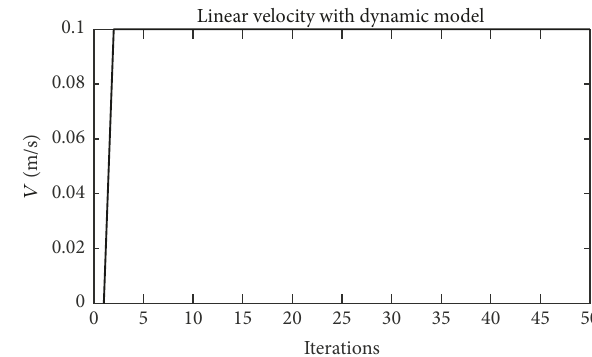
Figure 6: Linear velocity with the dynamic predictive control.